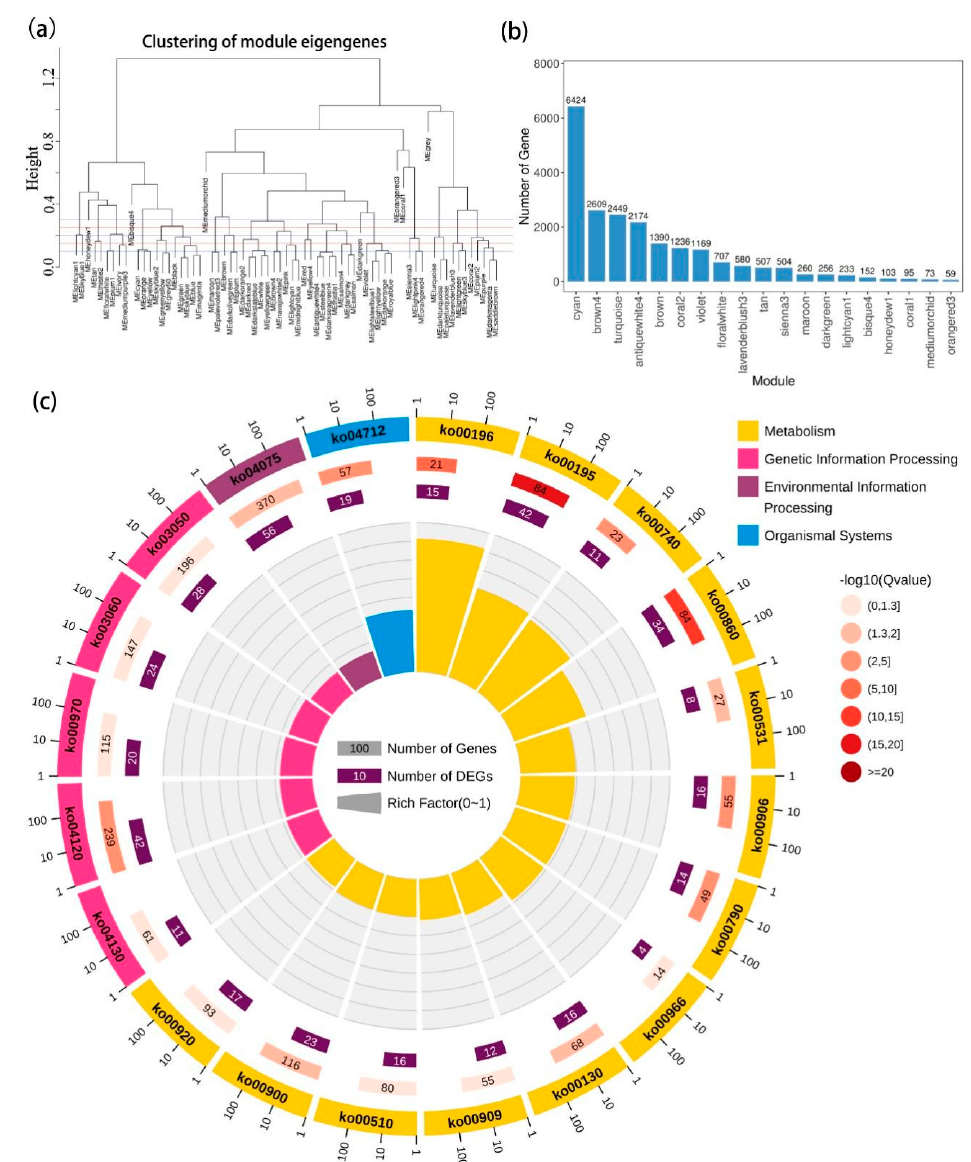
Figure 4. Gene co-expression network analysis. ( a ) Dendrogram showing modules identified by the weight gene co-expression network analysis and clustering dendrogram of module eigengenes; ( b ) The number of genes in each module; ( c ) KO (KEGG Ontology) enrichment circle diagram of cyan module (from the outside to the inside, the first circle represents the top 20 enrichment pathways, and the number outside the circle is the coordinate ruler of the number of genes; The second circle represents the number and Q value of background genes in this pathway, and the more genes, the longer the bar; The third circle represents the number of the DEGs in this pathway; The fourth circle represents the value of Rich Factor in each pathway) (Rich Factor refers to the ratio of DEGs to background genes).